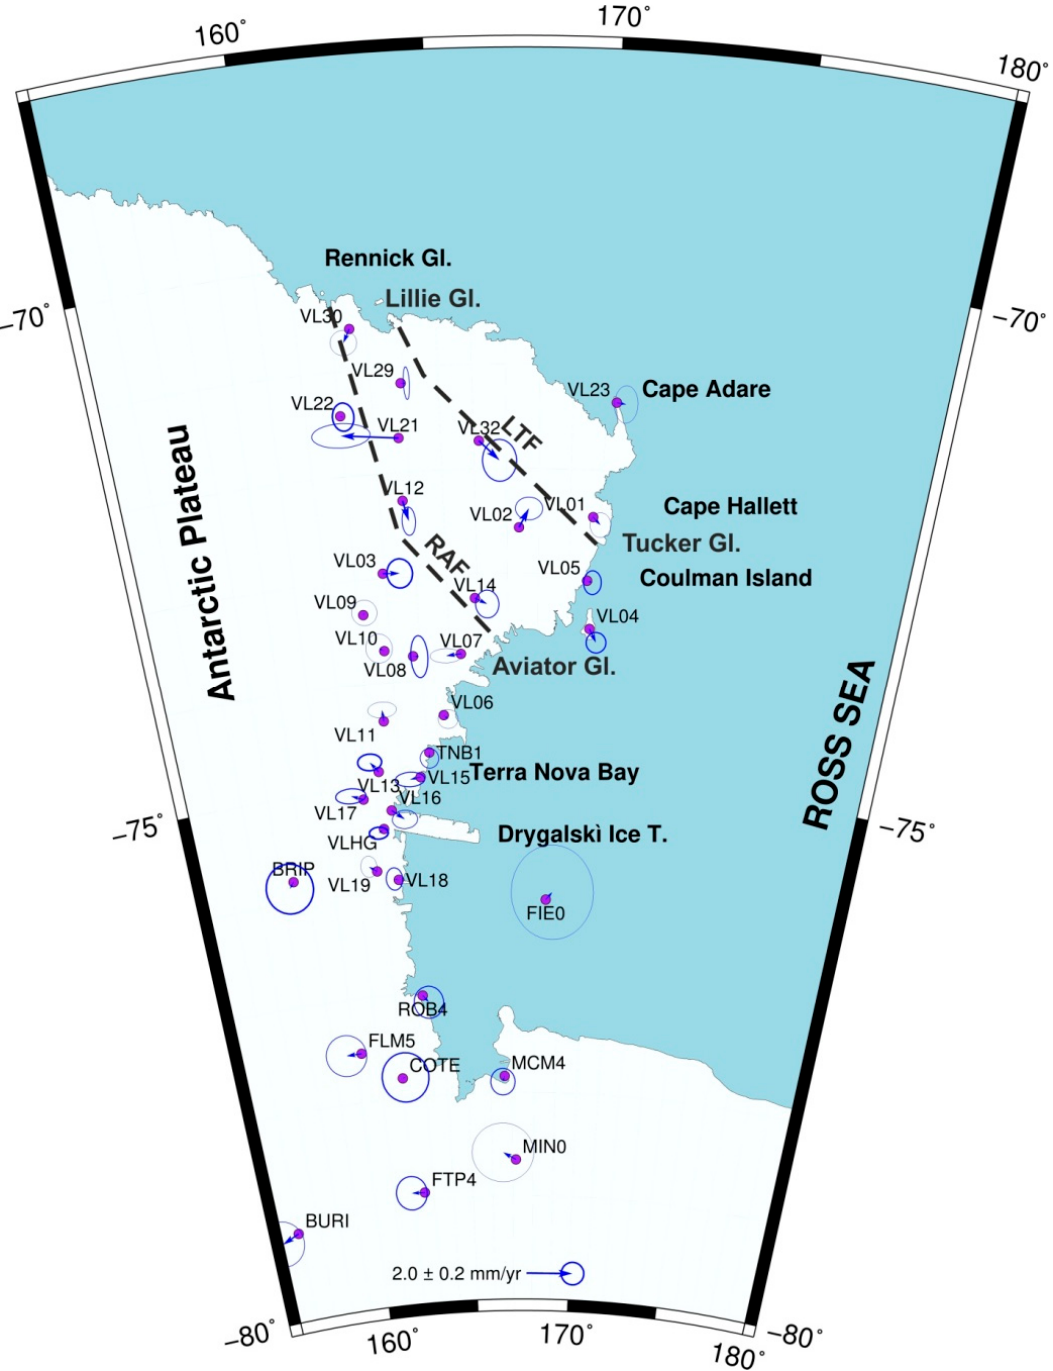
Figure 8. Residual horizontal displacement map (mm/yr) in Victoria Land (± σ ).